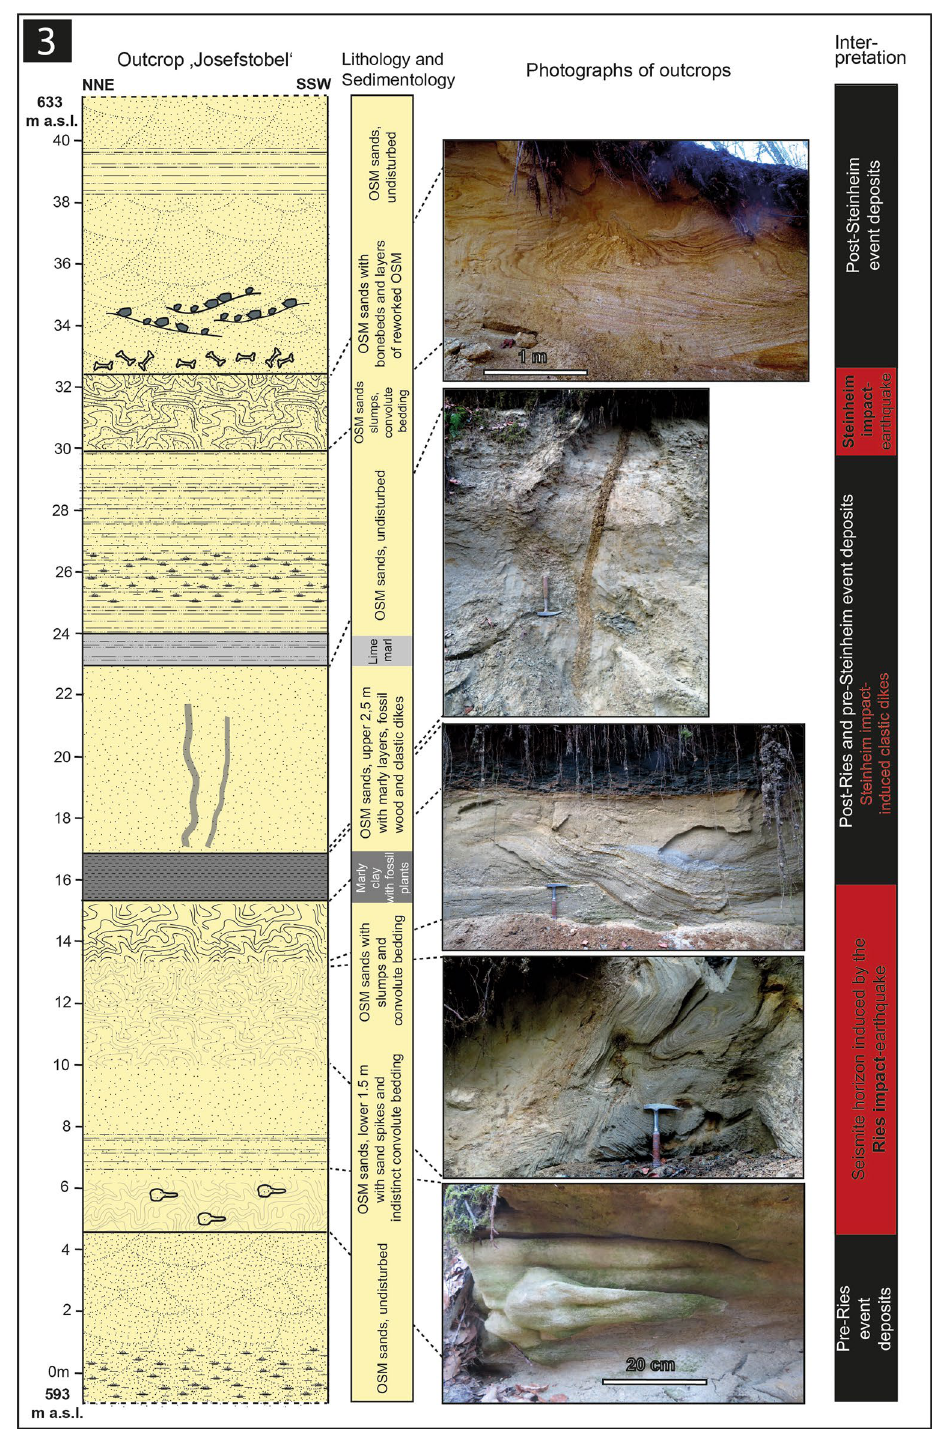
Figure 4. Schematic description of the sedimentological situation (left), outcrop photographs, and event stratigraphic interpretion of the sedimentologic succession (right) in the Josefstobel (Hochgeländ plateau south of Biberach an der Riß; outcrop no. 3 in the text). Two seismic events (Ries and Steinheim impact-earthquakes) are reported by the occurrence of two independent seismite horizons with slumps and convolute bedding within sediments that formed the land surface at the time of the two impact events. Additionally, the Steinheim impact-earthquake caused the formation of clastic dikes in deeper parts of the affected sediments. Usually, the Ries seismite is capped by distal Ries ejecta in several outcrops in the Hochgeländ area and elsewhere. In the Josefstobel, the distal Ries ejecta horizon is substituted by a dark claystone layer that resembles the K-Pg boundary layer to a certain degree (all photographs taken by V.J.S. in